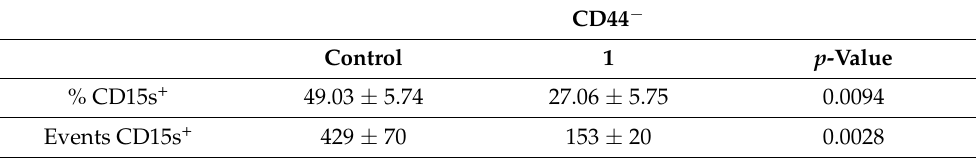
Table 2. Percentage and events of CD15s in CD44 − subpopulation after treatment with compound 1.